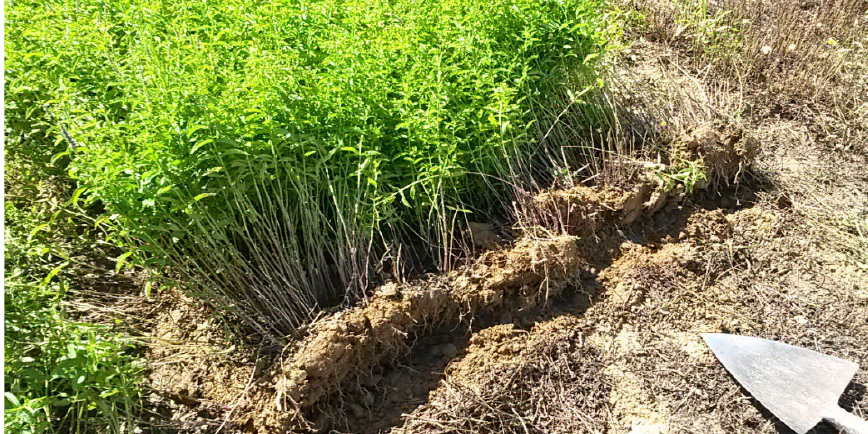
Figure 1. Plants of Mentha spicata were taken from the field to be used in the experiment. The stolons were separated from the plants’ epigeal parts and the bundles of capillary roots. Before being used in the laboratory, stolons were washed in running water to remove soil and other impurities. At the beginning of the experiment, each stolon was isolated in portions of 3–5 mm in length (propagules) containing one node each one. Subsequently, the nodes were subjected to surface disinfection under sterile conditions using a horizontal laminar flow cabinet. At the beginning, the propagules were immersed in an antioxidant solution containing ascorbic acid (100 mg L − 1 ); then they were immersed in an ethanol solution (65%) for 20 s and finally, the material was subjected to two rinses in sterile distilled water (Figure 2).